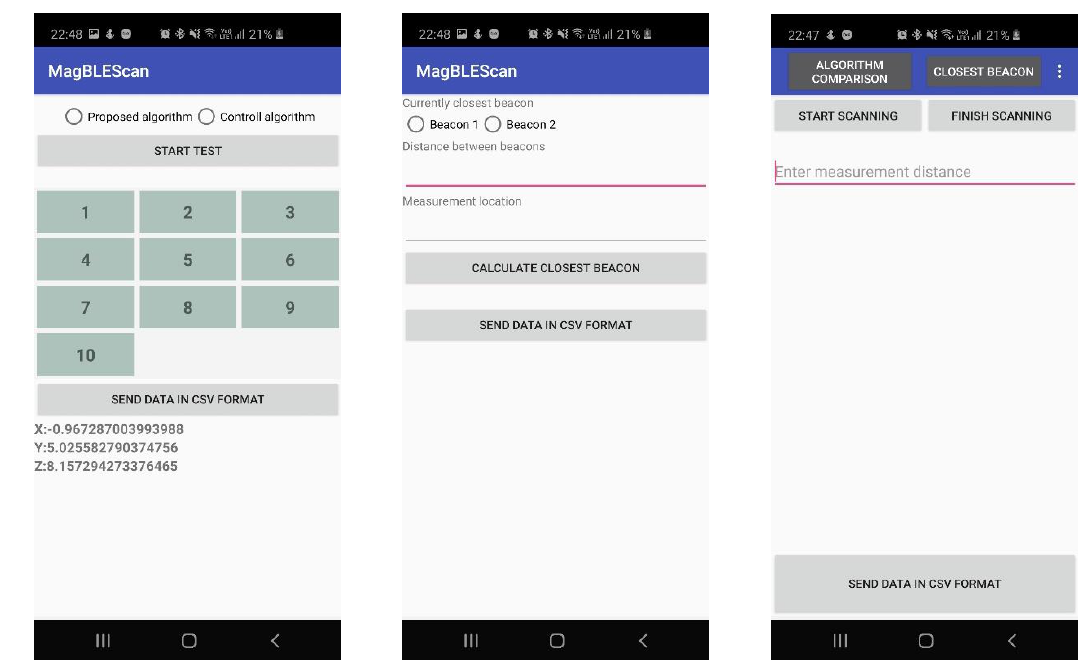
Figure 13. Screens of the diagnostic application used for measurements and data collection.